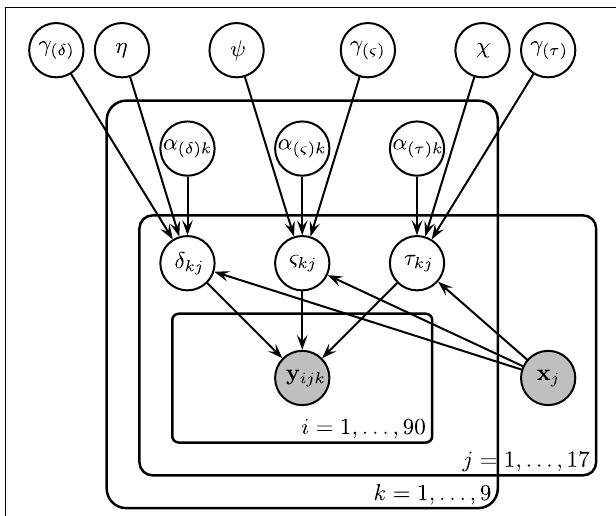
FIGURE 5 | Graphical representation of Model 3. Drift rates δ jk , diffusion coefficients ς jk , and non-decision times τ jk were assumed to vary over both conditions and participants. Each of these parameters are assumed to be drawn from normal distributions with means of the form α k + x (cid:2) j γ , where x j is the vector of SSVEP responses of subject j , and with variances that did not vary across conditions. As an example, α ( τ ) k is the condition effect on the non-decision time and γ ( τ ) reflects the change in non-decision time (seconds) due to a one SSVEP unit difference across two